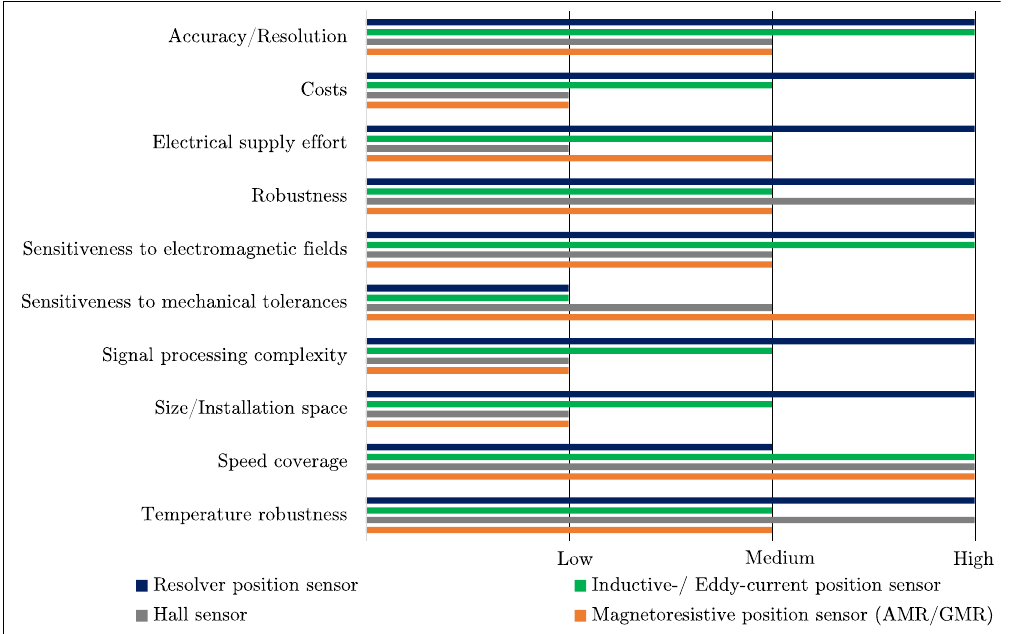
Figure 21. Comparison of the different sensor technologies related to selected performance indicators.